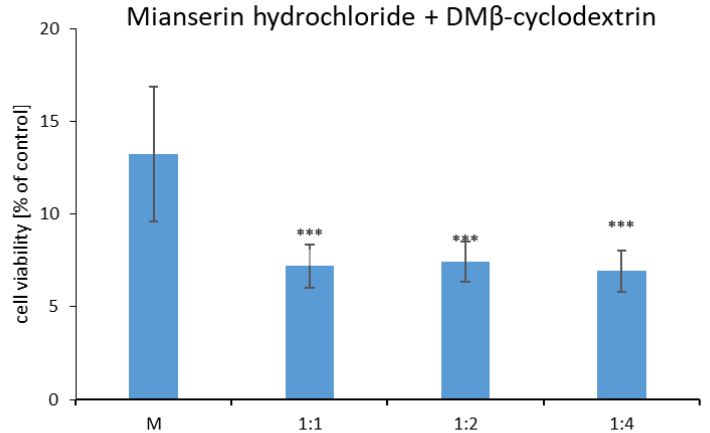
Figure 11. The Chinese hamster cells (B14) viability incubated with heptakis (2,6-di-O-methyl)- β - cyclodextrin after 24 h. Error bars represent S.D. ** p < 0.01 *** p < 0.001 confronted with the untreated cells.